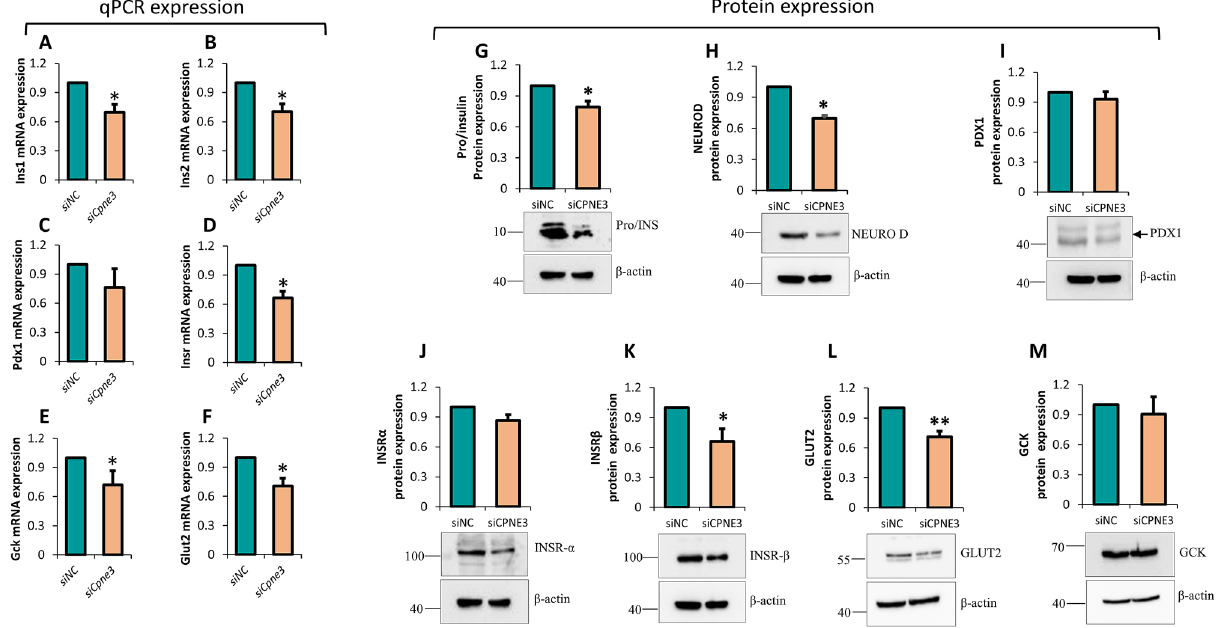
Figure 4. Impact of Cpne3 silencing on β-cell function genes. Total RNA and protein materials were extracted from Cpne3 -silenced cells or siRNA negative control 48 h post-transfection and subjected for qPCR and western blot analysis. ( A – F ) qPCR expression analysis of Ins1 , Ins2 , Pdx1, Glut2 , Insr and Gck . ( G – M ) Western blot analysis of Pro/insulin, NeuroD1, PDX1, INSRα, INSβ, GLUT2 and GCK relative to the endogenous control protein β-actin. Corresponding fold change in the intensity of the western are shown below each blot. We used the same β-actin for INSRβ and PDX1 as well for GLUT2 and GCK. Data are obtained from three independent experiments except for INSRα which was run twice. p-value. *p < 0.05 and **p < 0.01. Bars represent mean ±